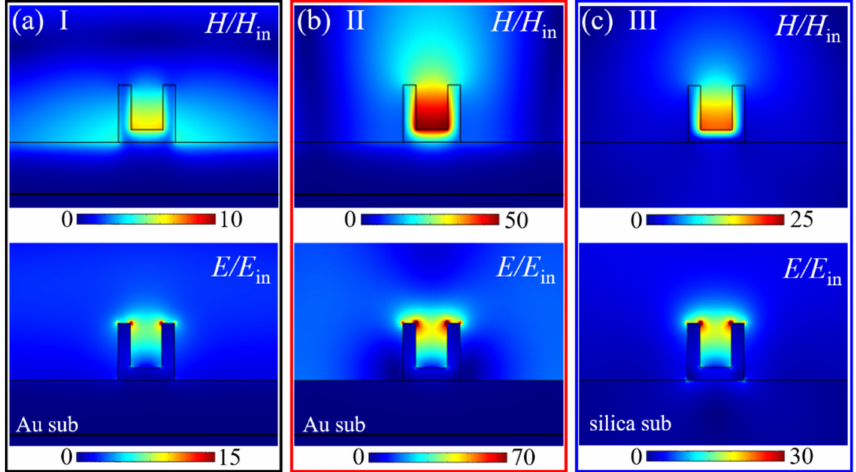
Figure 3. Normalized magnetic field ( H / H in ) and electric field ( E / E in ) distributions on the xoz plane for the dip I ( a ) and dip II ( b ) of the Au VSRRs on Au substrate and for the dip III ( c ) of the Au VSRRs on silica substrate.